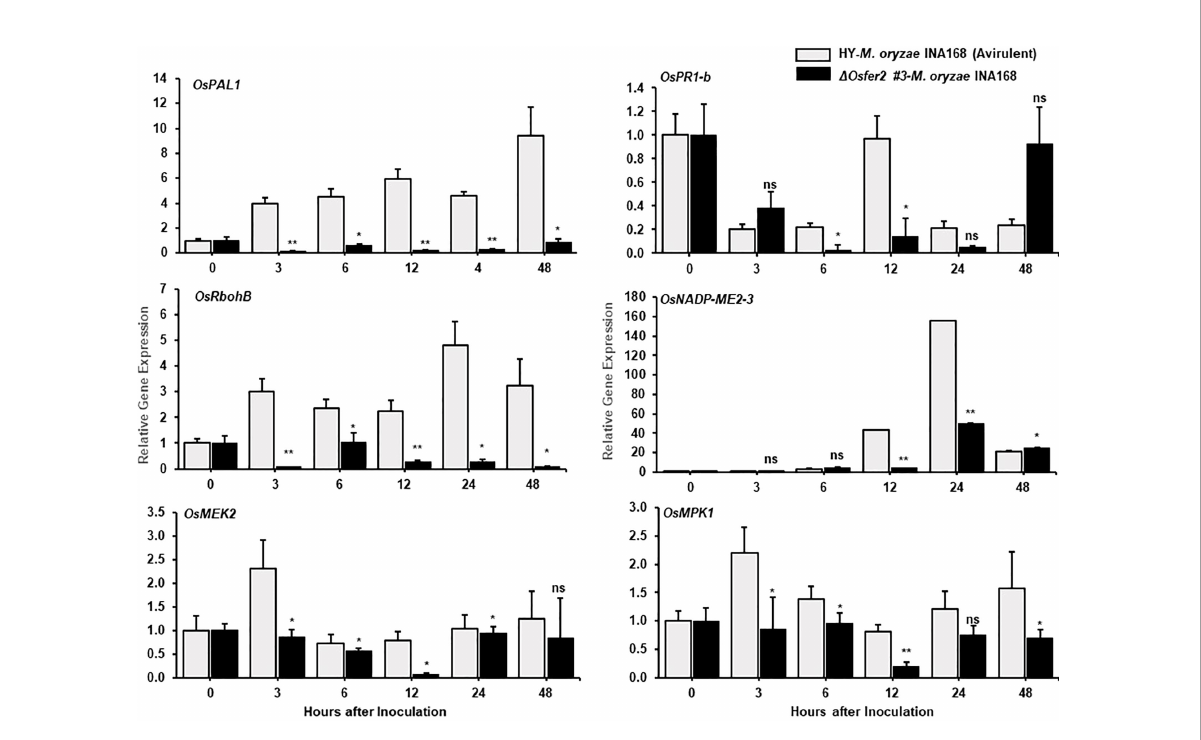
FIGURE 6 Quantitative real-time RT-PCR analyses of time-course expression of defense-related genes in rice HY and D Osfer2 mutant plants during avirulent Magnaporthe oryzae INA168 infection. Expression of rice defense-related genes, such as respiratory burst oxidase homologue B ( OsRbohB ), phenylalanine ammonia-lyase-like, ( OsPAL1 ), pathogenesis-related protein 1b ( OsPR1-b ), MAP kinase kinase 2 ( OsMEK2 ), mitogen- activated protein kinase 1 ( OsMPK1) and NADP-malic enzyme ( OsNADP-ME2-3 ) were analyzed by qRT-PCR. Relative expression levels in rice leaf sheaths were calculated using the corresponding values at 0 hpi (control) after normalizing with respect to the expression of the internal control OsUbiquitin. Asterisks indicate statistically signi fi cant differences (Student ’ s t -test, * P < 0.05 and ** P < 0.01), ns, not signi fi cant.